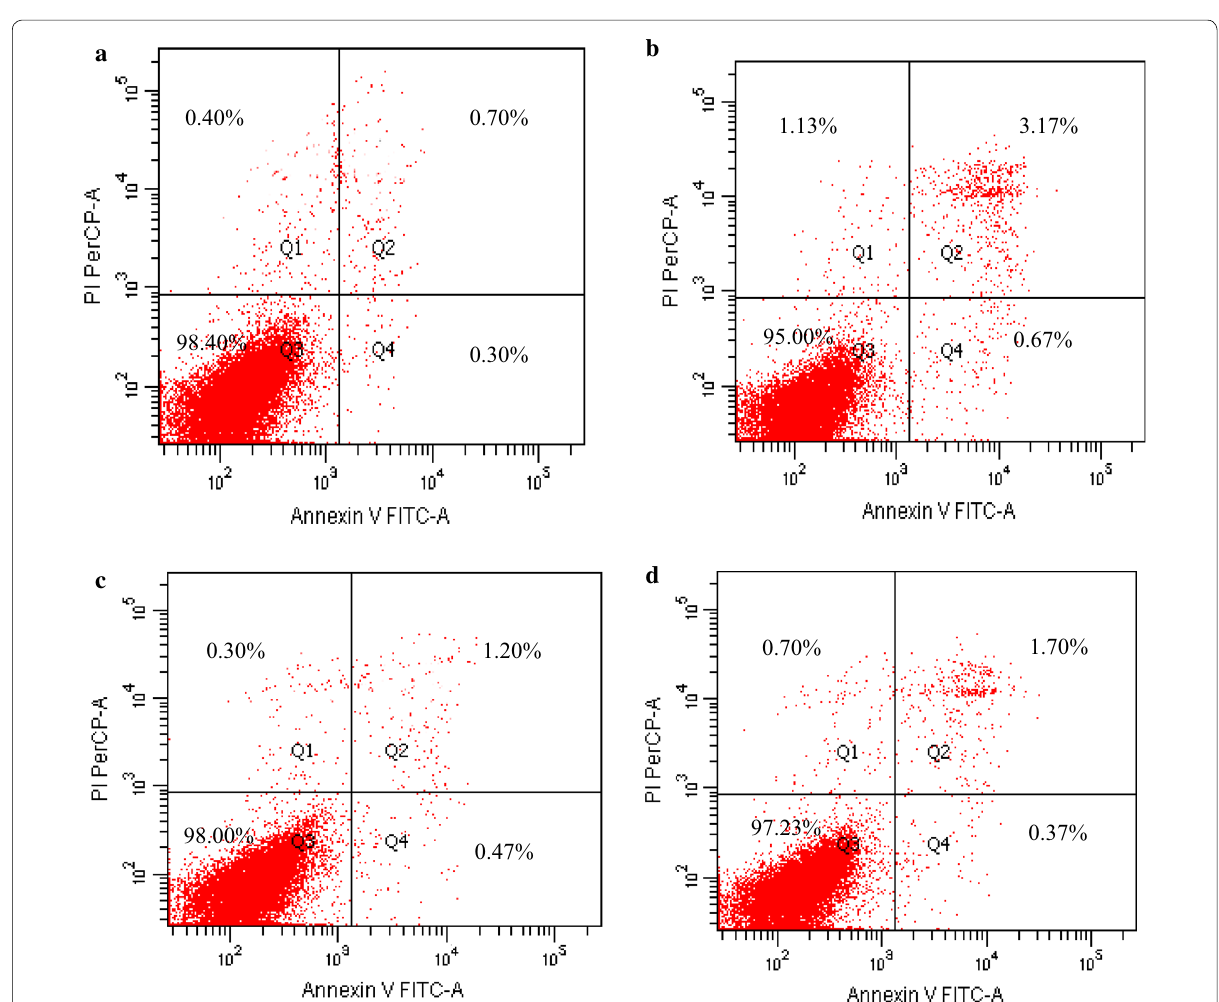
Fig. 2 Effect of S. cerevisiae on protecting IPEC‑J2 cell from damage induced by DON after incubating for 8 h. IPEC‑J2 cells were treated without DON and S. cerevisiae ( a , the control group), 4 µM DON ( b ), S. cerevisiae ( c ), and S. cerevisiae figure are the means of percentages in different cell statuses, 6 replicates for each treatment. Q1‑4 represents necrotic, late apoptotic, viable and early apoptotic cells,